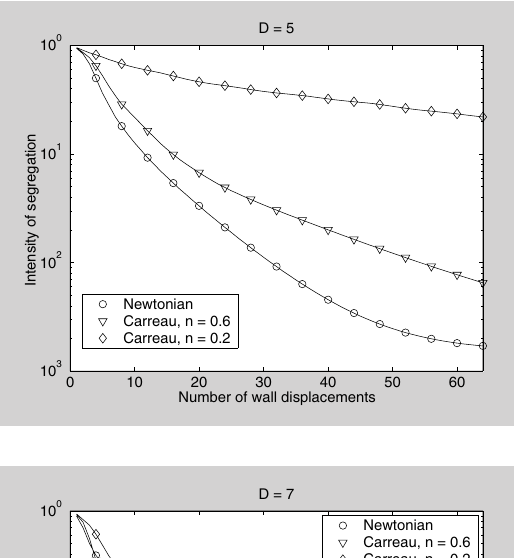
Figure 7: Shear-thinning results for the TBTB